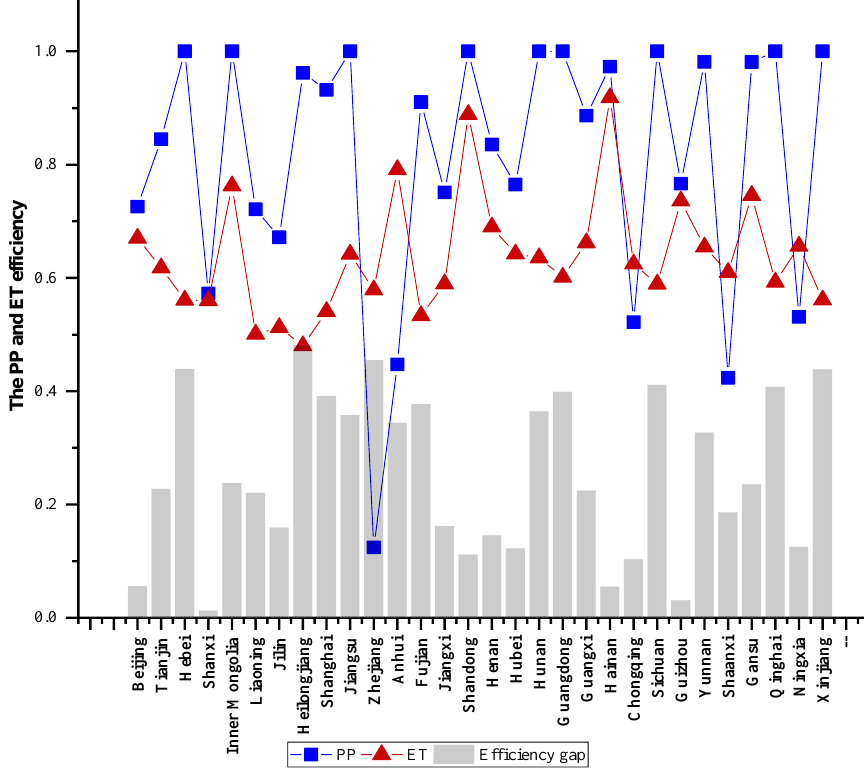
Figure 6. Average efficiency and gap of PP and ET stage. Figure 6. Average e ffi ciency and gap of PP and ET stage.